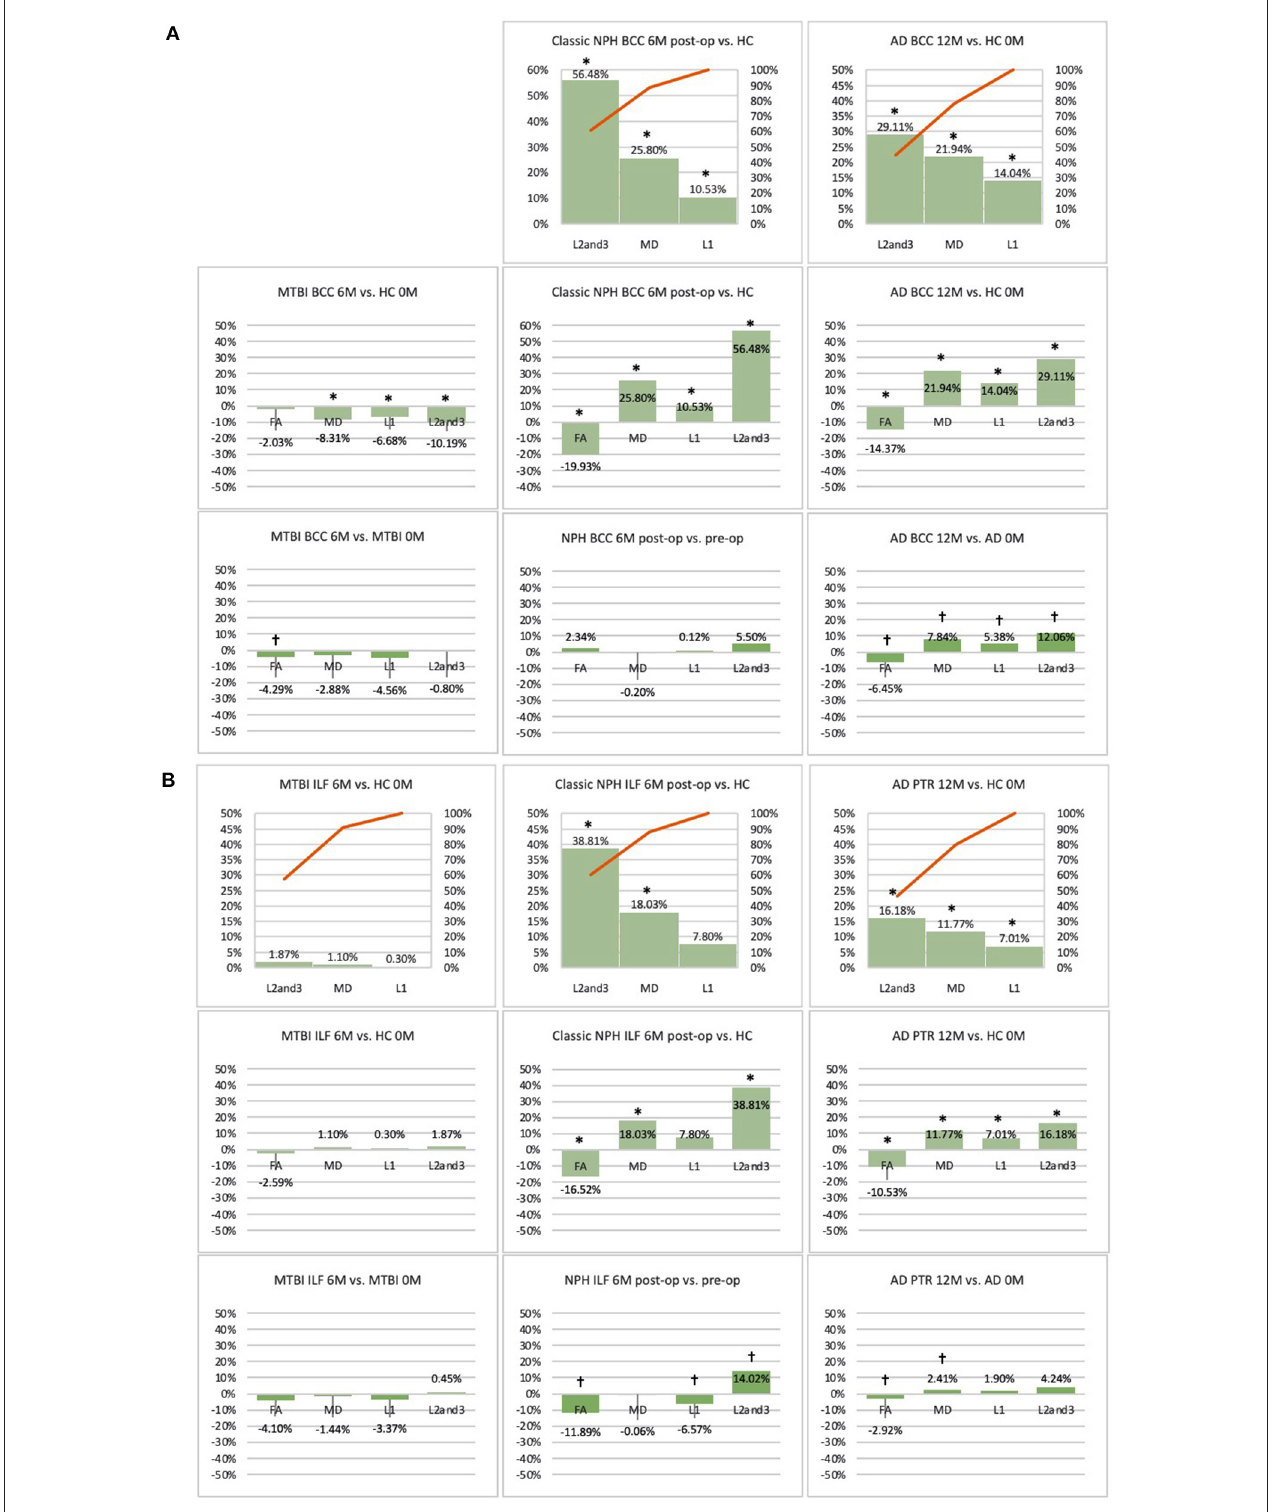
FIGURE 5 | (A) Midline (BCC) and (B) lateral (ILF or PTR) ROI families at follow-up. At 6 or 12-month follow-up, percentage changes in DTI measures of clinical cohorts are compared against corresponding healthy controls at baseline, presented as Pareto graphs and bar charts. At this time point, patients are also compared to themselves at baseline, presented as bar charts. We observed that, in MTBI, the BCC ROI at 6-month follow-up demonstrated an unique profile (significant decreases in mean, axial and radial diffusivity measures in the context of a non-significant decrease in FA). We suggest this is possibly indicative of processes seen in